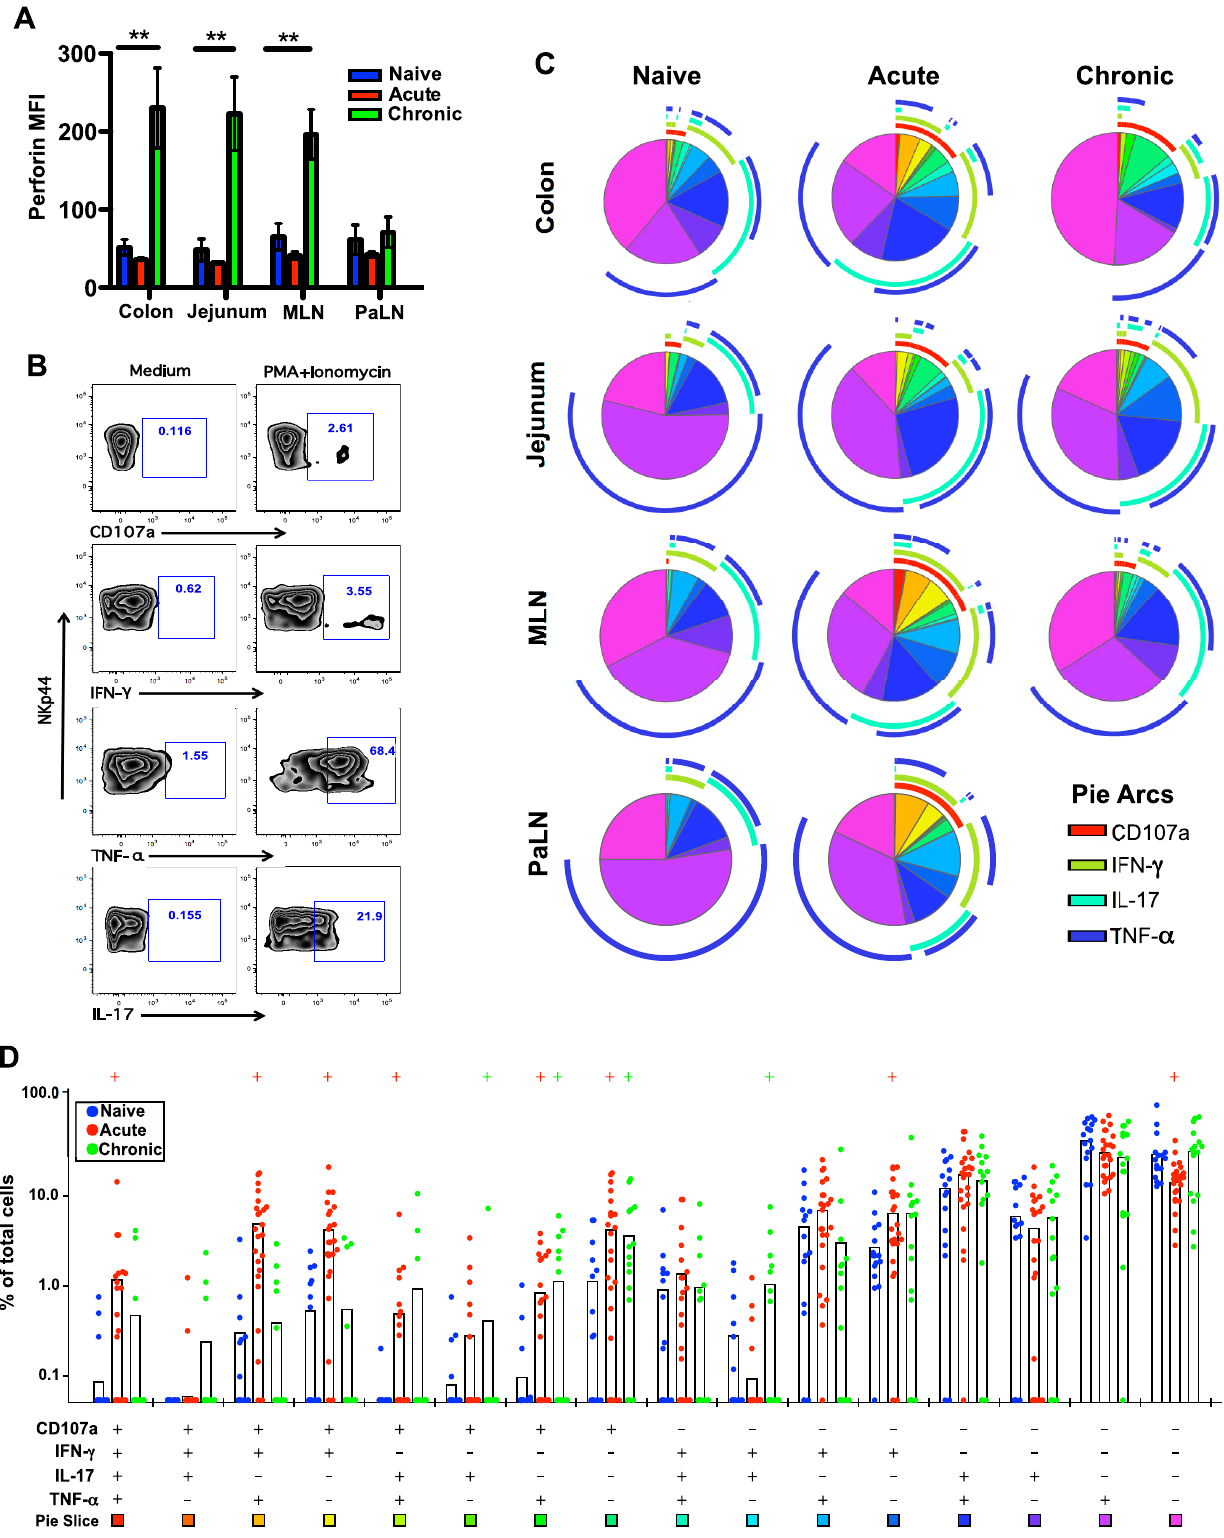
Fig. 4. Comparison of NKp44 + ILC functions within naı¨ve, acute and chronically SIV-infected macaques. (A) Median fluorescence intensities (MFI) of perforin expression in NKp44 + ILCs ex vivo. (B) Representative flow cytometry plots demonstrating cytokine-secretion profiles of mucosal NKp44 + ILCs following mitogen stimulation. (C) Multiparametric analyses on the data shown in (B) were performed with SPICE 5.0 software. Pies indicate means of 6 to 8 animals per group for each multifunction and arcs show overlap of individual functions. (D) Combined tissue bar comparisons of individual multifunctions. Multifunctions are indicated by rainbow color boxes beneath each combination and correspond to the